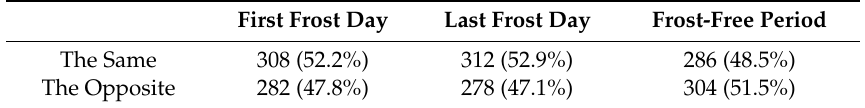
Table 4. The number and percentage (in bracket) of the sites where the observed and gridded frost data are with the same climate trends (OGSP index) and opposite climate trends in mainland China.